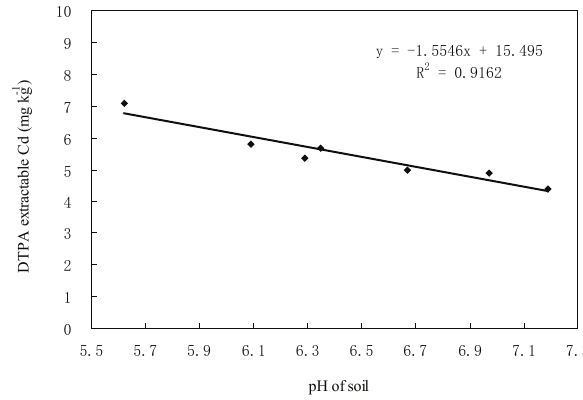
Figure 4: Relationship between soil available cadmium content and cadmium concentrations in different tissues of tobacco plants.